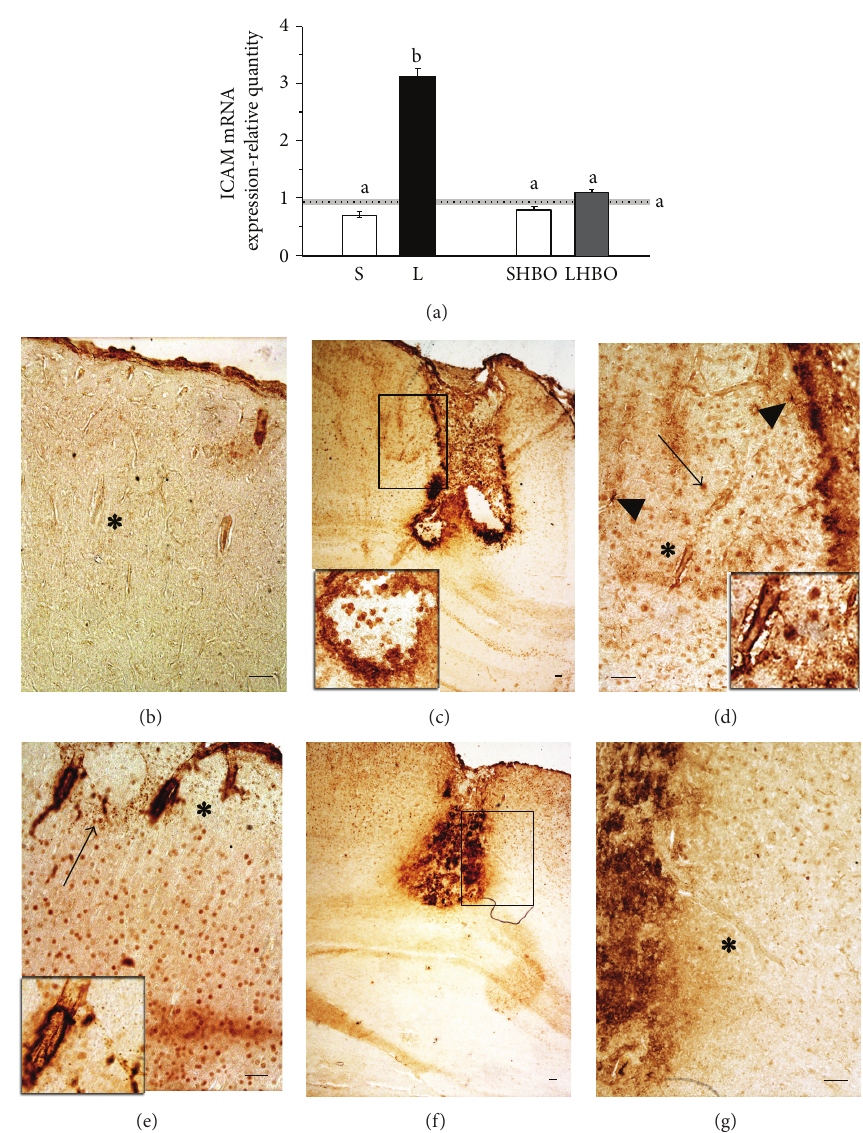
Figure 3: Repetitive HBOT reduces gene and tissue expression of ICAM-1 after CSI. (a) Repetitive HBOT attenuated injury-induced upregulationofICAM-1mRNAexpressionintheinjuredcortex.Barsrepresentmean ± SEMofICAM-1mRNA(relativetoGAPDH).Samples are from 4 animals per each group. Dot line represents mean of ICAM-1 mRNA level ± SEM (gray area) measured in control animals. Letters indicate significance levels ( 𝑃 < 0.005 ) between lesioned (L) and intact control groups, L versus sham control (S) group, and L compared to lesioned group subjected to the HBO protocol (LHBO). The groups not sharing a common letter are statistically different. Level of significance was analyzed using Student’s 𝑡 -test. (b) In the control cortex ICAM-1 localization is present on the blood vessels (asterisk). ((c) and (d)) An increased ICAM-1 immunoreactivity is seen around the lesion site after the CSI. Heavy immunostaining of blood vessels is demonstrated both in ipsilateral (asterisk (d) and (e) inset) and contralateral cortex (asterisk (e) and (e) inset). The arrow denotes dark neuron-like cells in injured (d) and contralateral cortex (e). ICAM-1-positive neutrophils, microglia ((c), (c) inset), and astrocyte-like cells ((d), arrow head) were confined to the lesion area. (f) and (g) Repetitive HBOT reduced ICAM-1 immunoreactivity, while blood vessels were faintly stained ((g) asterisk). Rectangles indicate where the high magnification images are taken from. Scale bar = 50 𝜇